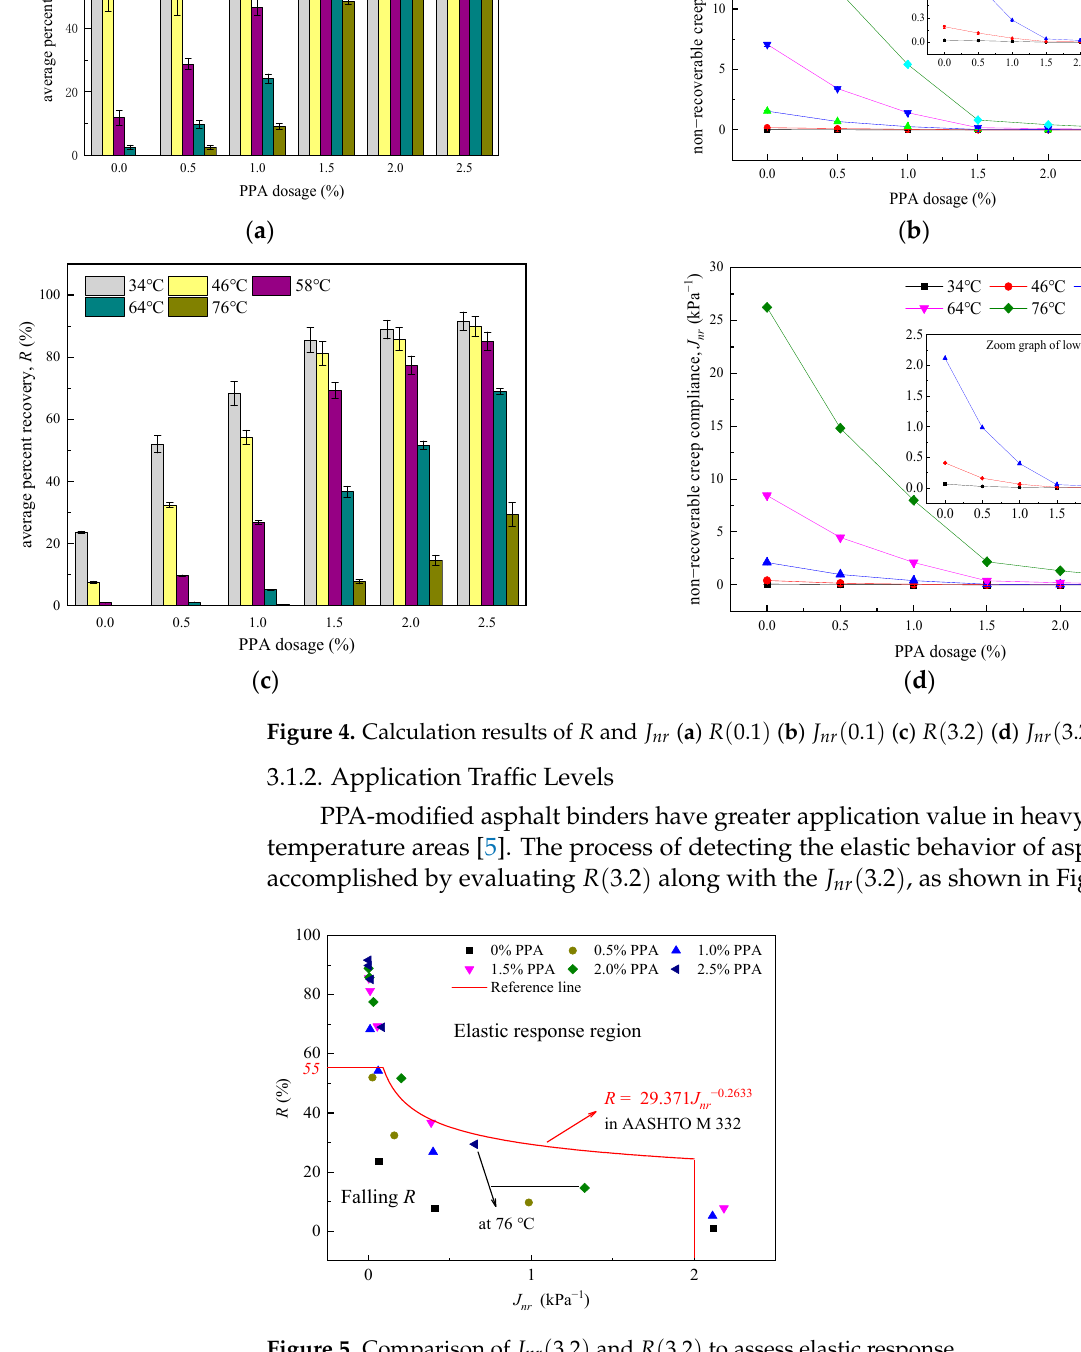
( b ) Figure 6. Percent di ff erence in 𝑅 and 𝐽 (cid:3041)(cid:3045) between 0.1 kPa and 3.2 kPa ( a ) 𝑅 (cid:3031)(cid:3036)(cid:3033)(cid:3033) , ( b ) 𝐽 (cid:3041)(cid:3045)(cid:3031)(cid:3036)(cid:3033)(cid:3033) . Enlarge Figure 4d and plot recommended values of 𝐽 (cid:3041)(cid:3045) (3.2) (see Table 2) in Figure 7 to determine the applicable tra ffi c levels for PPA-modi fi ed asphalt binders.